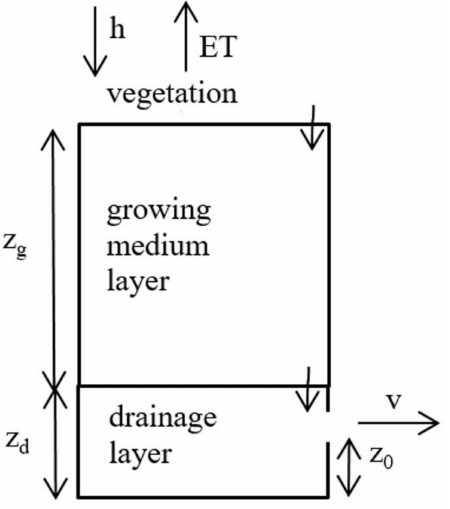
Figure 1. Conceptual scheme considered for the modeling of green roofs. h : rainfall depth; ET : evapotranspiration volume; v : runoff volume; z g : growing medium thickness; z d : drainage layer thickness; z 0 : overflow